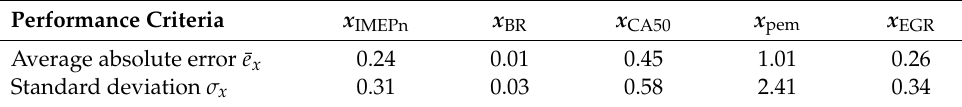
Figure 9. Transient RCCI engine performance for the proposed engine speed-load cycle: open-loop versus closed-loop results (PFI-to-SPI E85 mass flow ratio of 100%:0%). Reprinted from [19] with permission of the International Federation of Automatic Control 2020. Table 8. Cylinder-averaged tracking results for the studied test